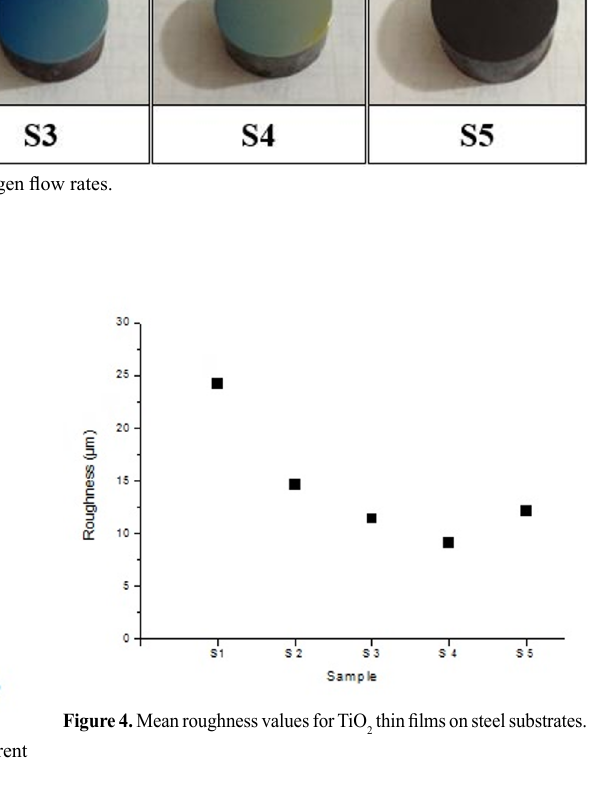
Figure 2. XRD patterns of theTiO argon/oxygen flow rates.